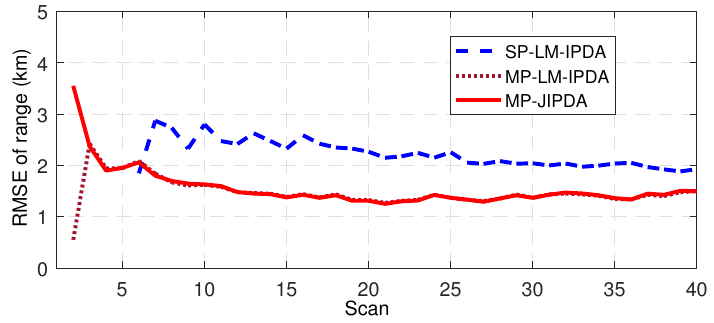
Figure 5. RMSE of range for Target